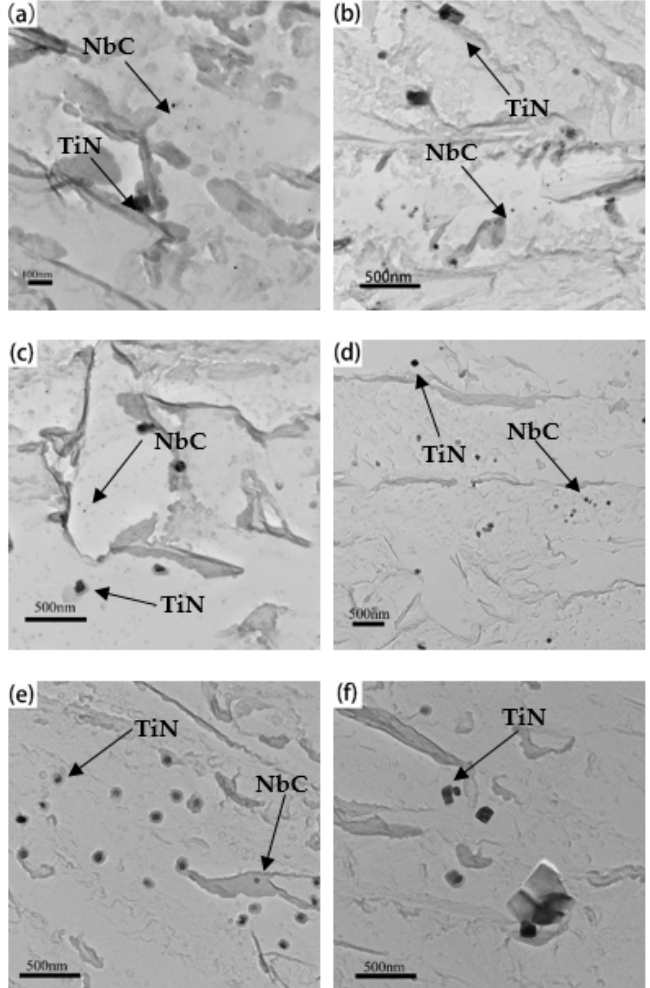
Figure 5. Precipitates in the carbon extraction replicas after holding at 950 °C and 1050 °C for ( a , b ) 0.5 h, ( c , d ) 3 h, ( e , f ) 5 h.